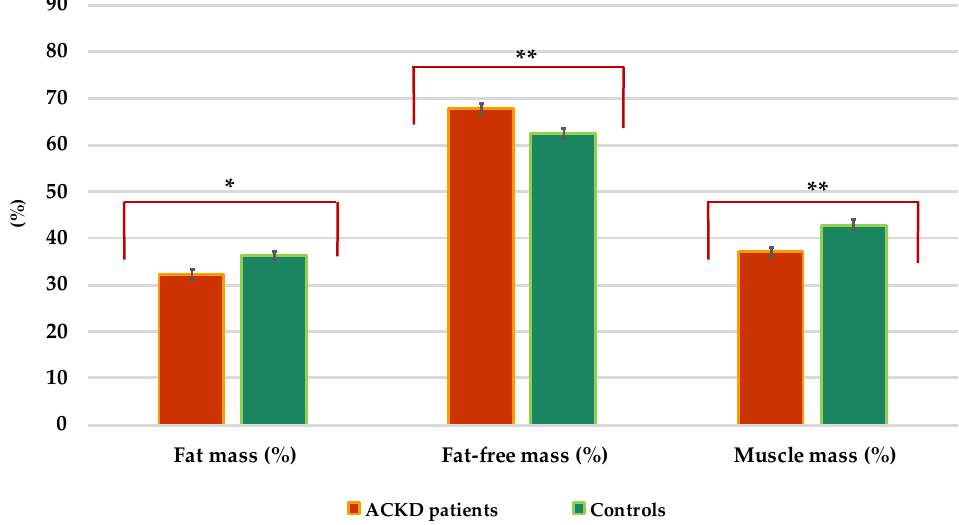
Figure 3. Distribution of the body composition parameters in patients with advanced chronic kidney disease and controls. * p = 0.006, ** p < 0.001. Values are expressed in percentages (%).